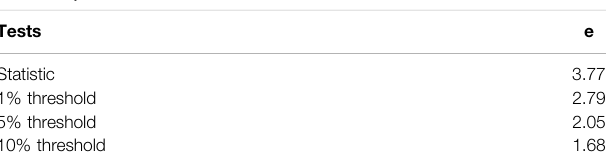
TABLE 5 | EG-ADF test